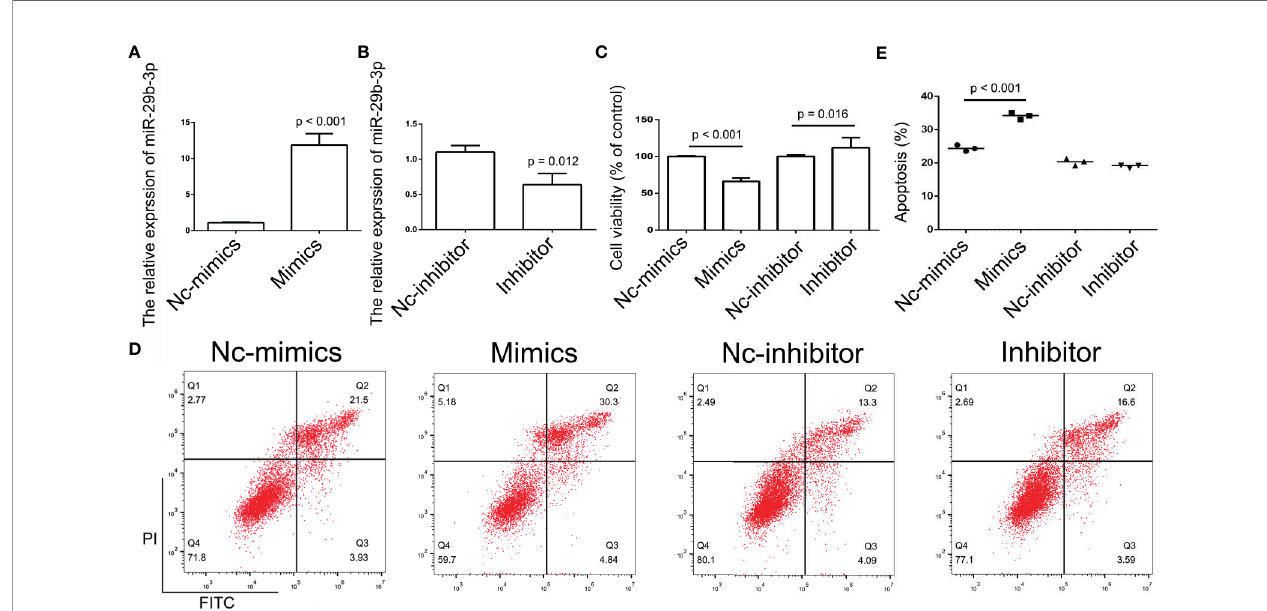
FIGURE 6 | Analysis of miR-29b-3p expression. (A, B) Relative expression of miR-29b in the Nc-mimics, miR-29b-3p-mimics, Nc-inhibitor, and miR-29b-3p- inhibitor groups, utilizing qPCR in SCC9 cells. Data are represented as mean ± SD (n = 3). (C) Cell growth was assessed by the CCK-8 assay in SCC9 cells to determine the effect of miR-29b-3p on cell proliferation. (D) Cell apoptosis was analyzed after transfection with miR-29b-3p-mimics and miR29b-3p-inhibitor in SCC9 cells to determine the effect of miR-29b-3p on cell apoptosis. (E) Statistical analysis of the percentage of cell apoptosis among the four groups. Statistical signi fi cances between groups were evaluated using t-test for independent groups.